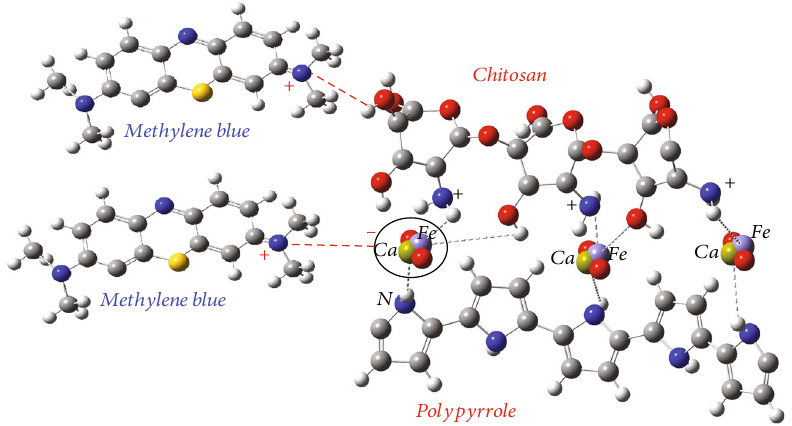
Figure 7: Molecular structure of PPy-Chi-CaFe